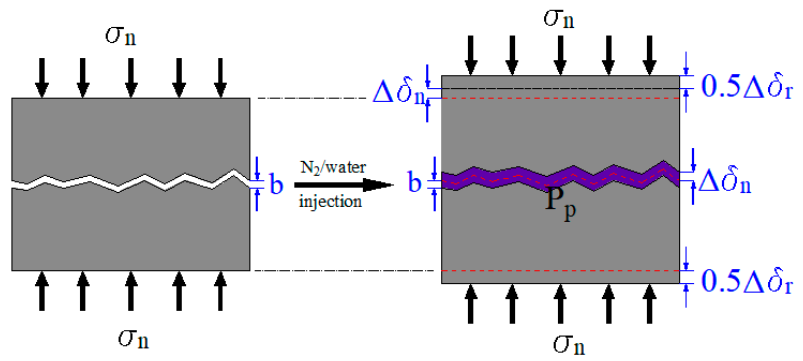
Figure 9. Schematic diagram of the normal deformation of jointed sample affected by pore pressure.